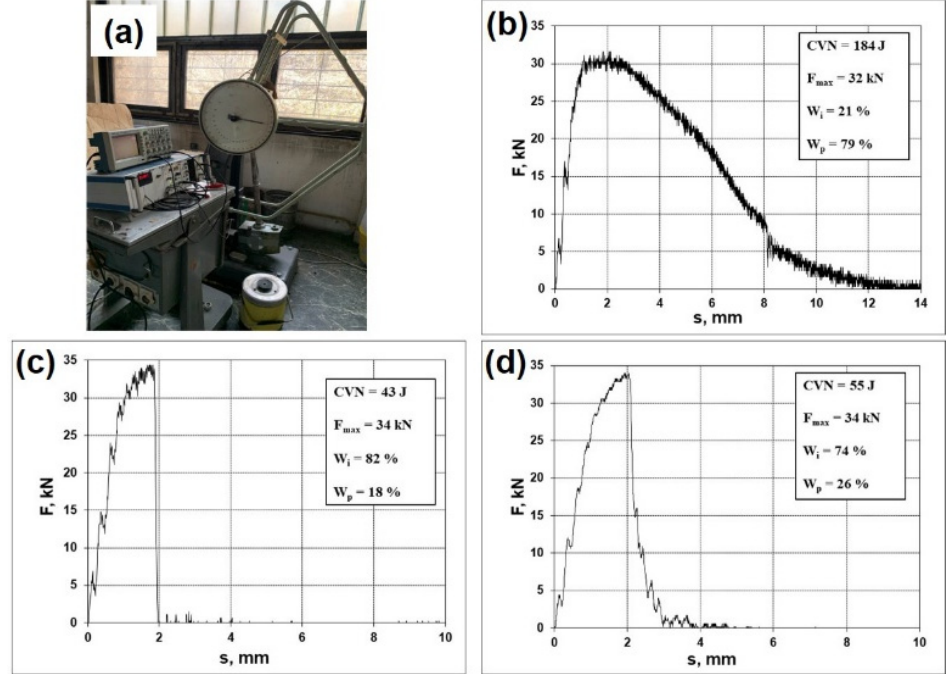
Figure 14. ( a ) Experimental setup of Instrumented Charpy V-notch impact test; Force displacement graphs; ( b ) BM; ( c ) HAZ; ( d ) FZ.